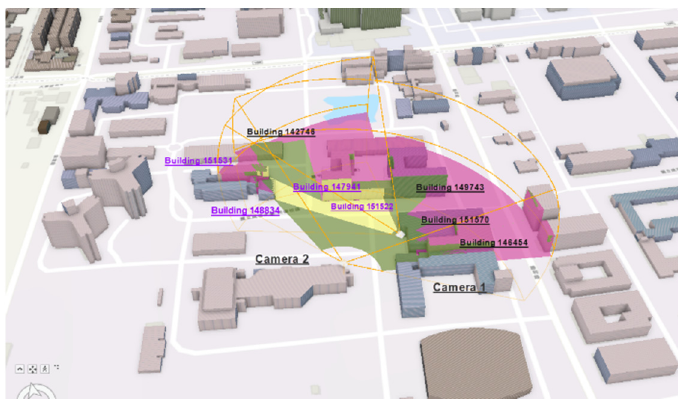
Figure 18. CCTV FOV analysis during the day time.